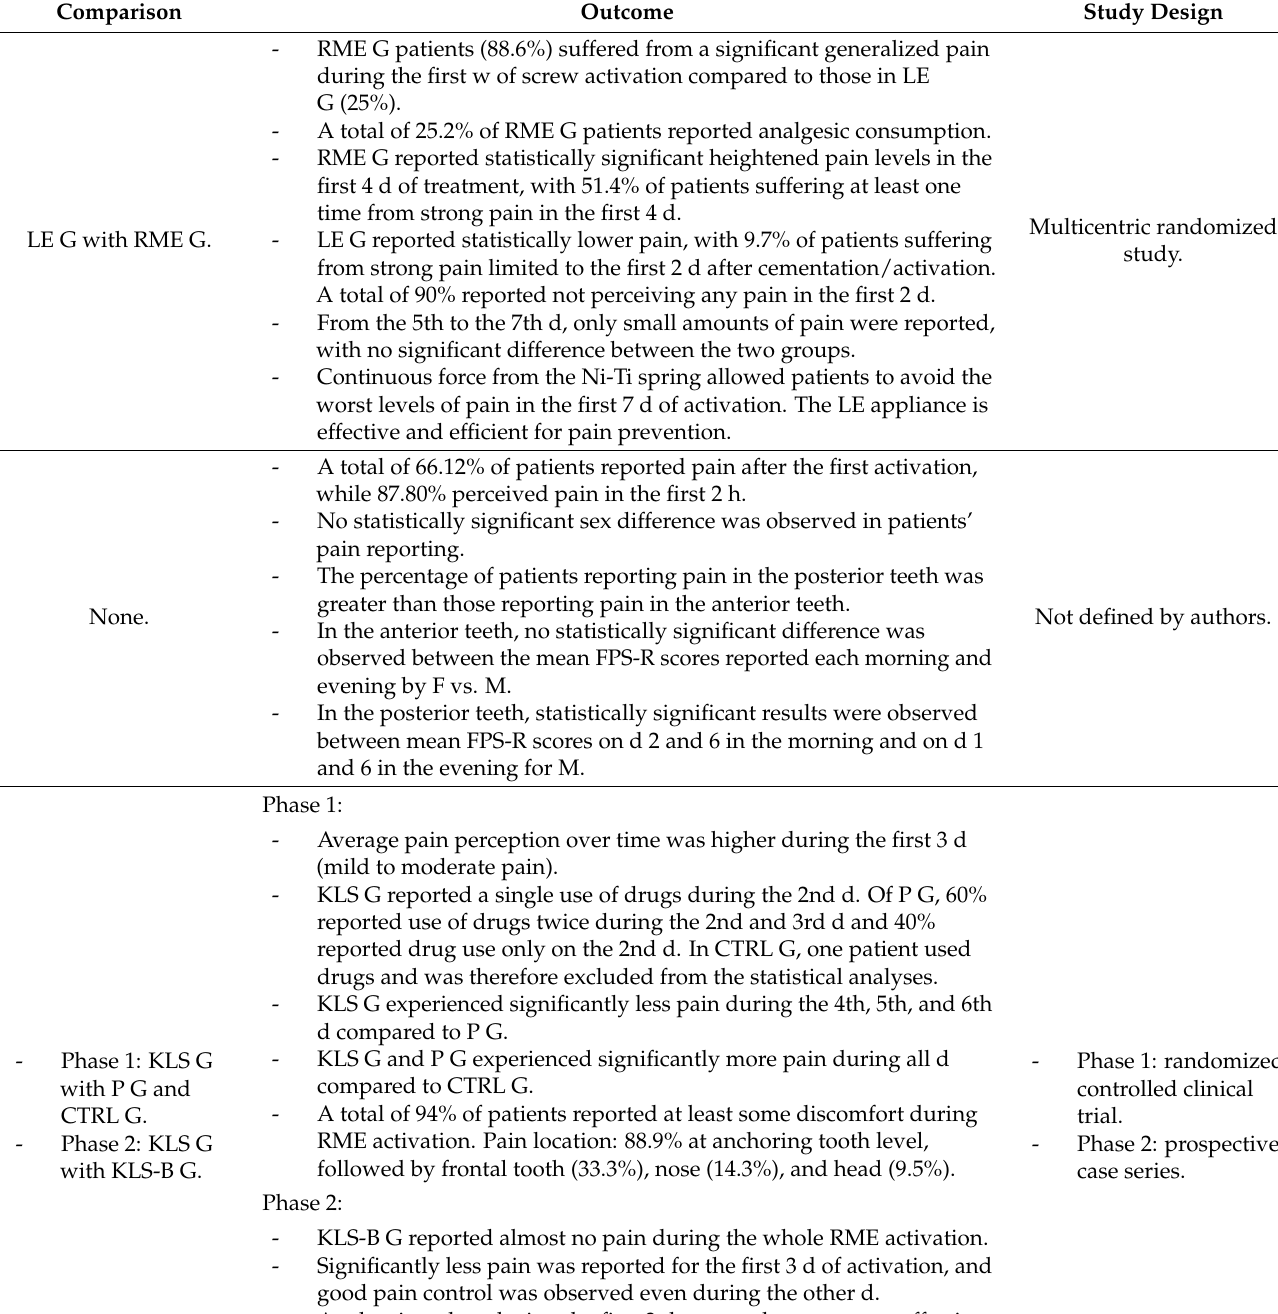
Comparison Outcome Study